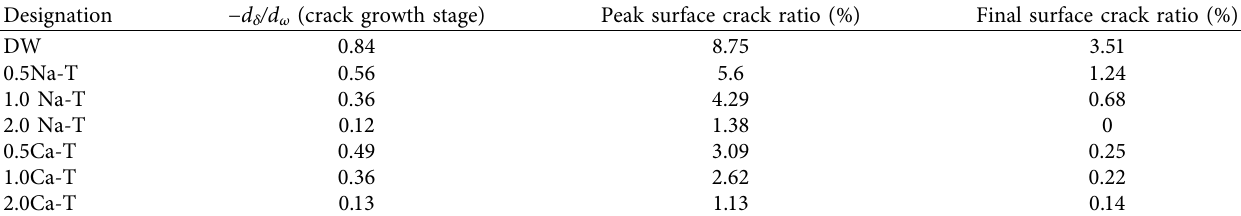
Figure 9: Variation of surface crack ratio ( δ ) with water content ( ω ) for specimens saturated with CaCl Table 4: Associated parameters of the cracking for different